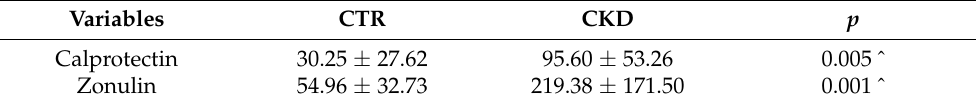
Table 3. Baseline measures associated with intestinal mucosa inflammation (calprotectin, µ g/g)